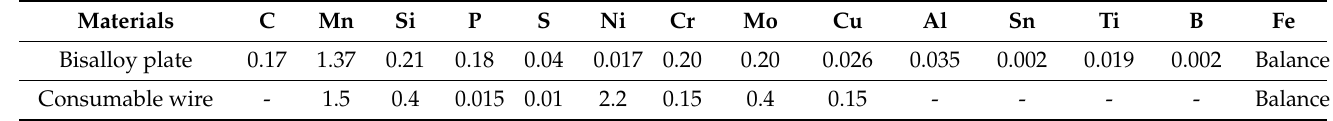
Figure 1. ( a ) Welded plate of Bisalloy 80 steel. ( b ) Schematic diagram to show the clamp locations at the back of plates used during welding of the samples (note: the rolling direction of the plate is perpendicular to the welding direction). Table 1. Chemical composition for 20 mm Bisalloy 80 steel plate and the consumable